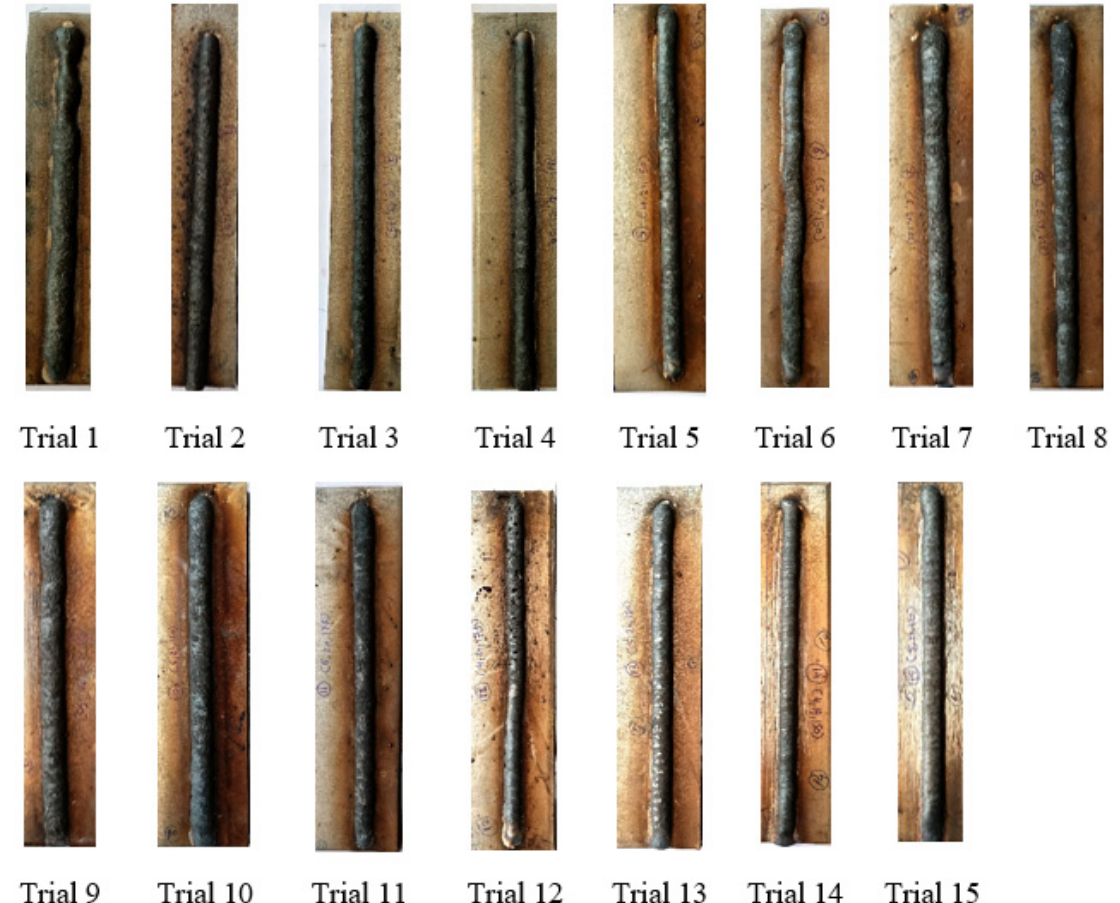
Figure 2. Single-layered deposition on 316L substrate.